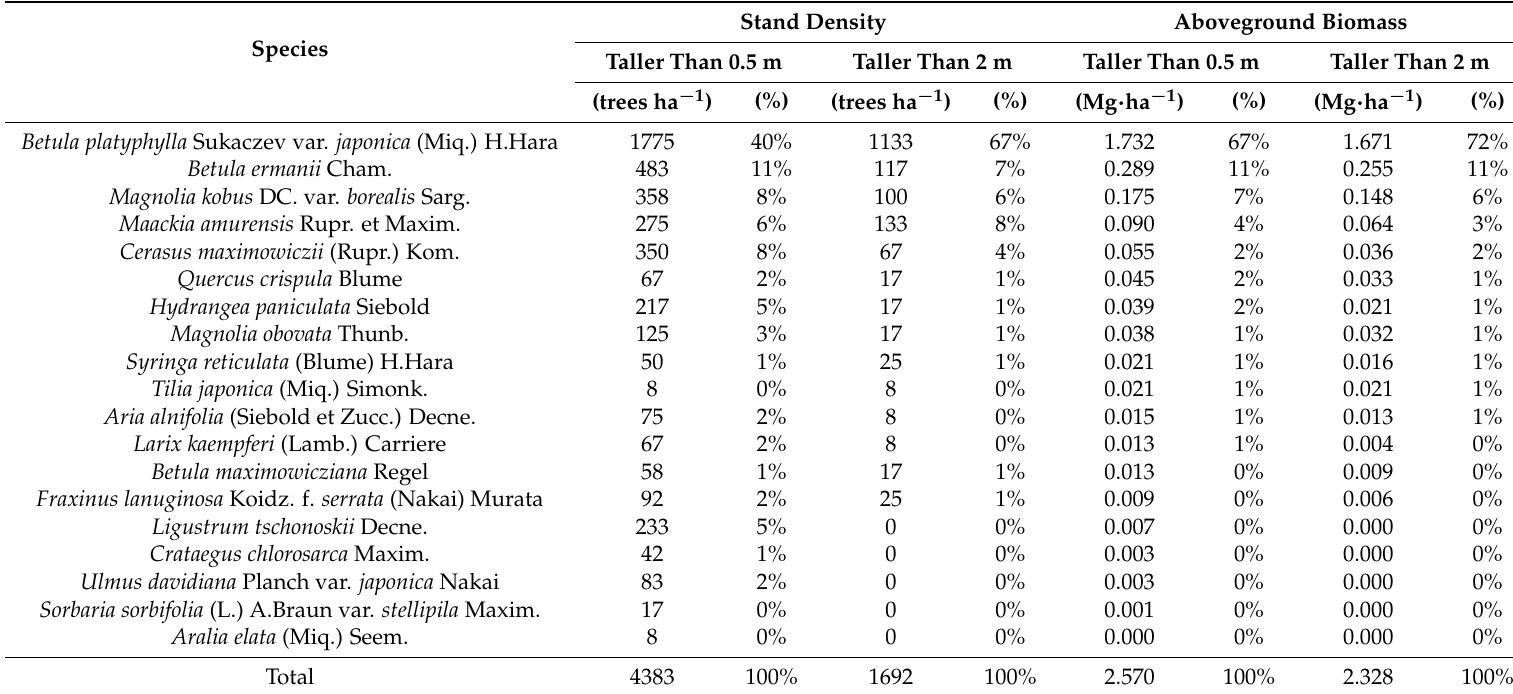
83 2% 0 0% 0.003 0% 0.000